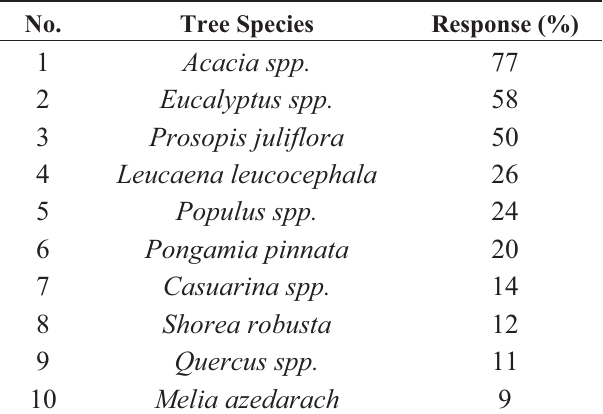
Table 2. Suitable tree species for energy wood plantation on government and private uncultivated lands ( N = 31). No.